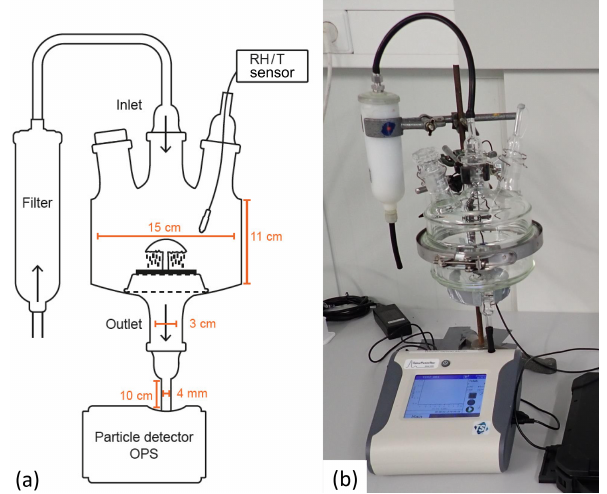
Figure 4. Setup used for laboratory experiments. The samples are placed in a glass cuvette in a vertical air stream. Air is supplied via an inlet with a filter connected to it; the outlet is connected to an OPS for particle measurements. A temperature and humid- ity (RH/ T ) sensor is placed inside the cuvette via an opening in the upper lid, which is sealed to avoid contamination. (a) Schematic drawing, and (b) close-up